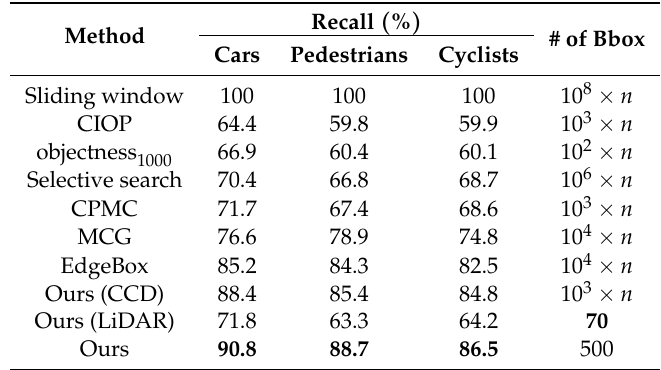
Table 3. Recall of each object-region proposal method. # of Bbox denotes the number of bounding box in the KITTI data. The bold numbers in the recall column represent the highest recall except for the sliding window (because the sliding window always contains 100%). The bold component in # of Bbox represent the smallest number among the entire